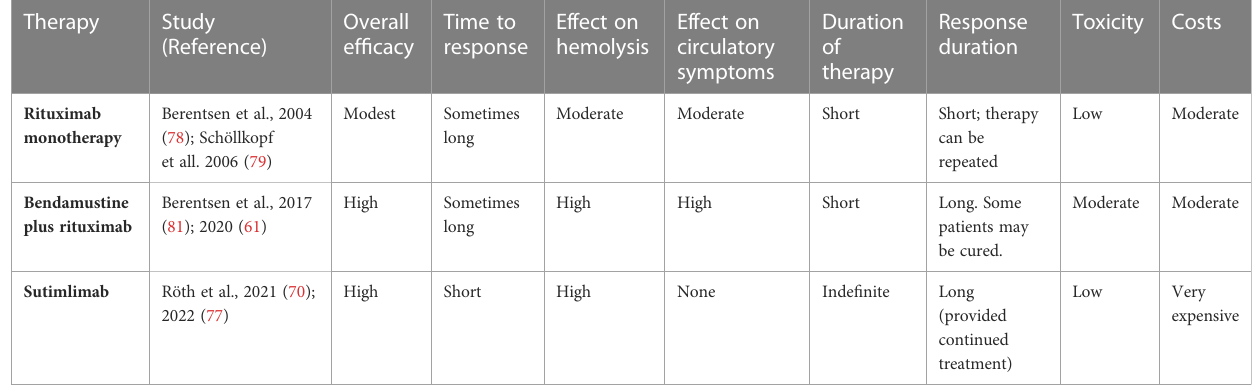
TABLE 4 B-cell directed versus complement-directed therapies in